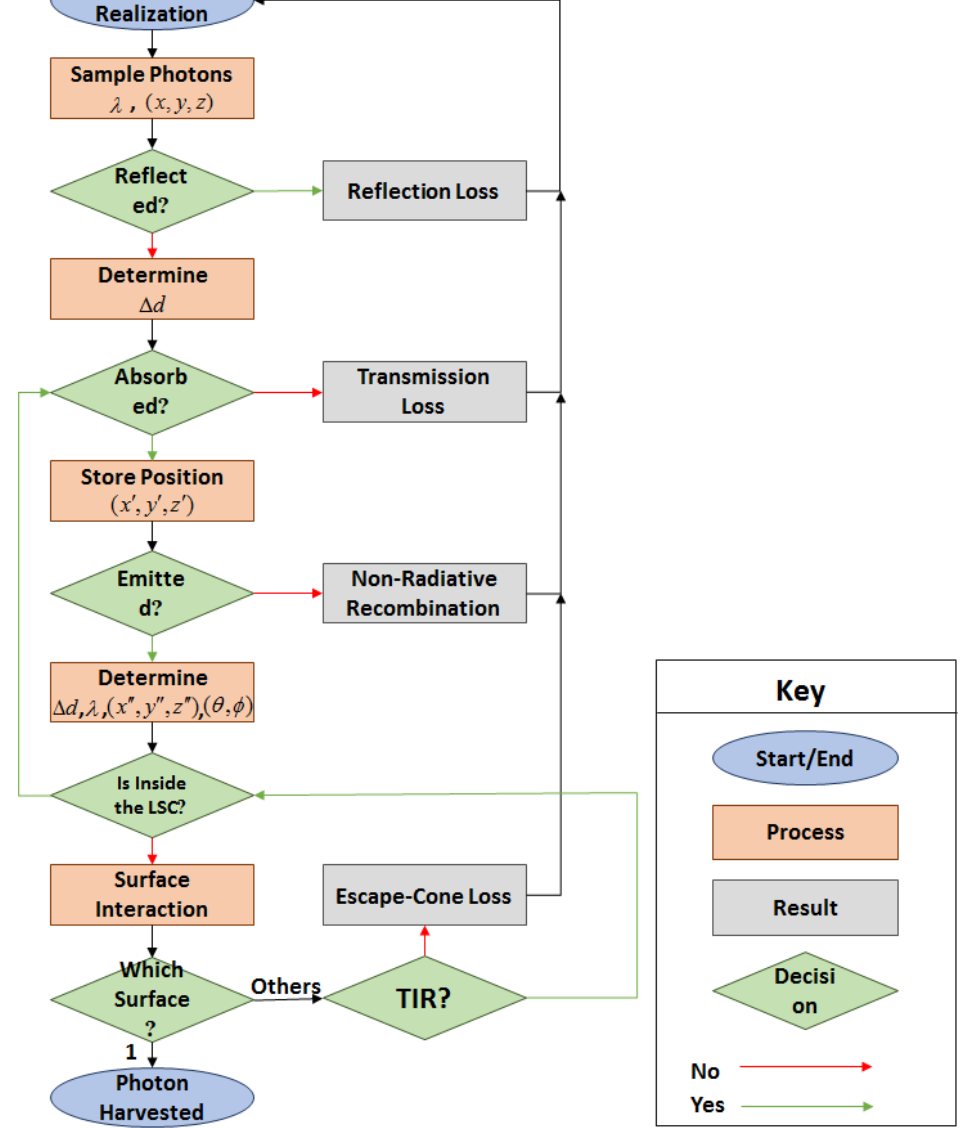
Figure 3. Monte-Carlo algorithm for numerical simulation.